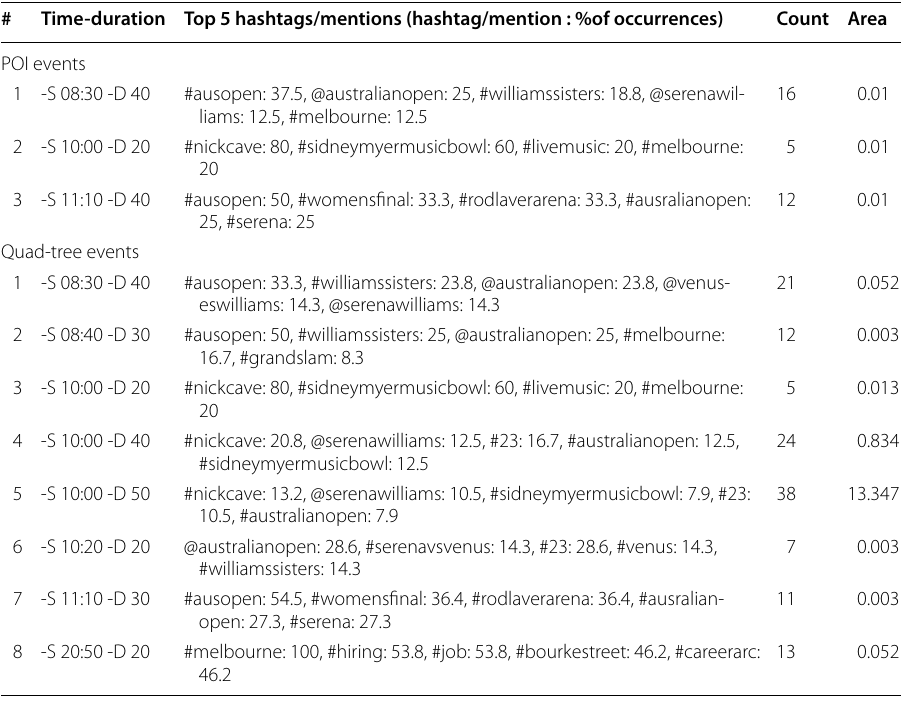
Table 9 Melbourne detected events in 28-January 2017 using each of POI and Quad-tree methods Time‑duration Top 5 hashtags/mentions (hashtag/mention : %of